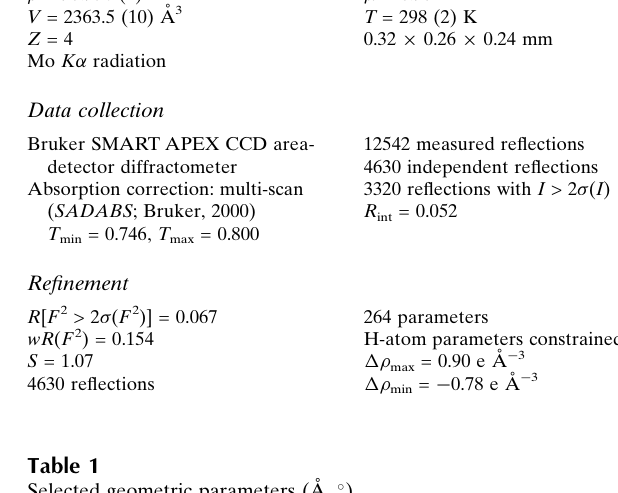
Selected geometric parameters (A˚ , (cid:3) ).